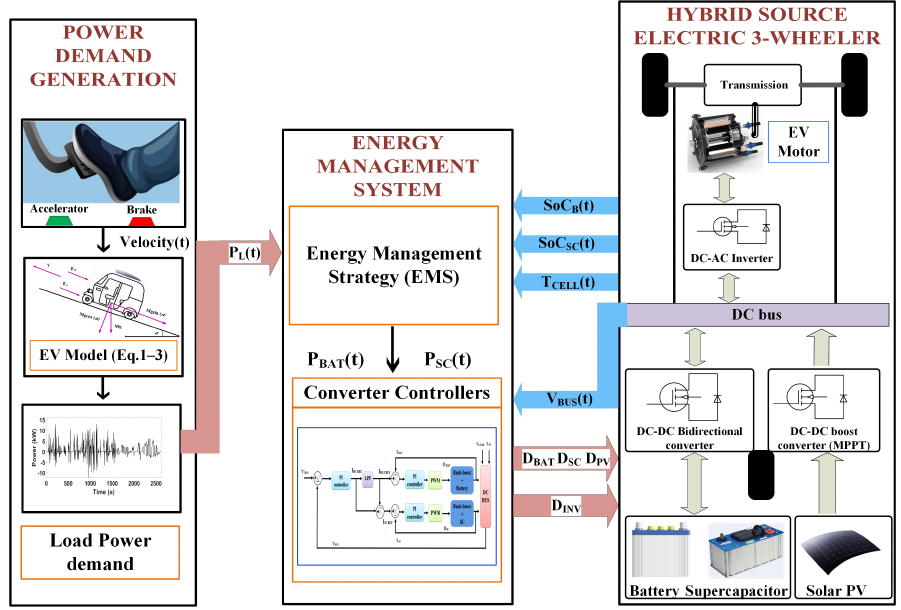
Figure 2. Schematic structure of hybrid-source energy management in electric three-wheeler.